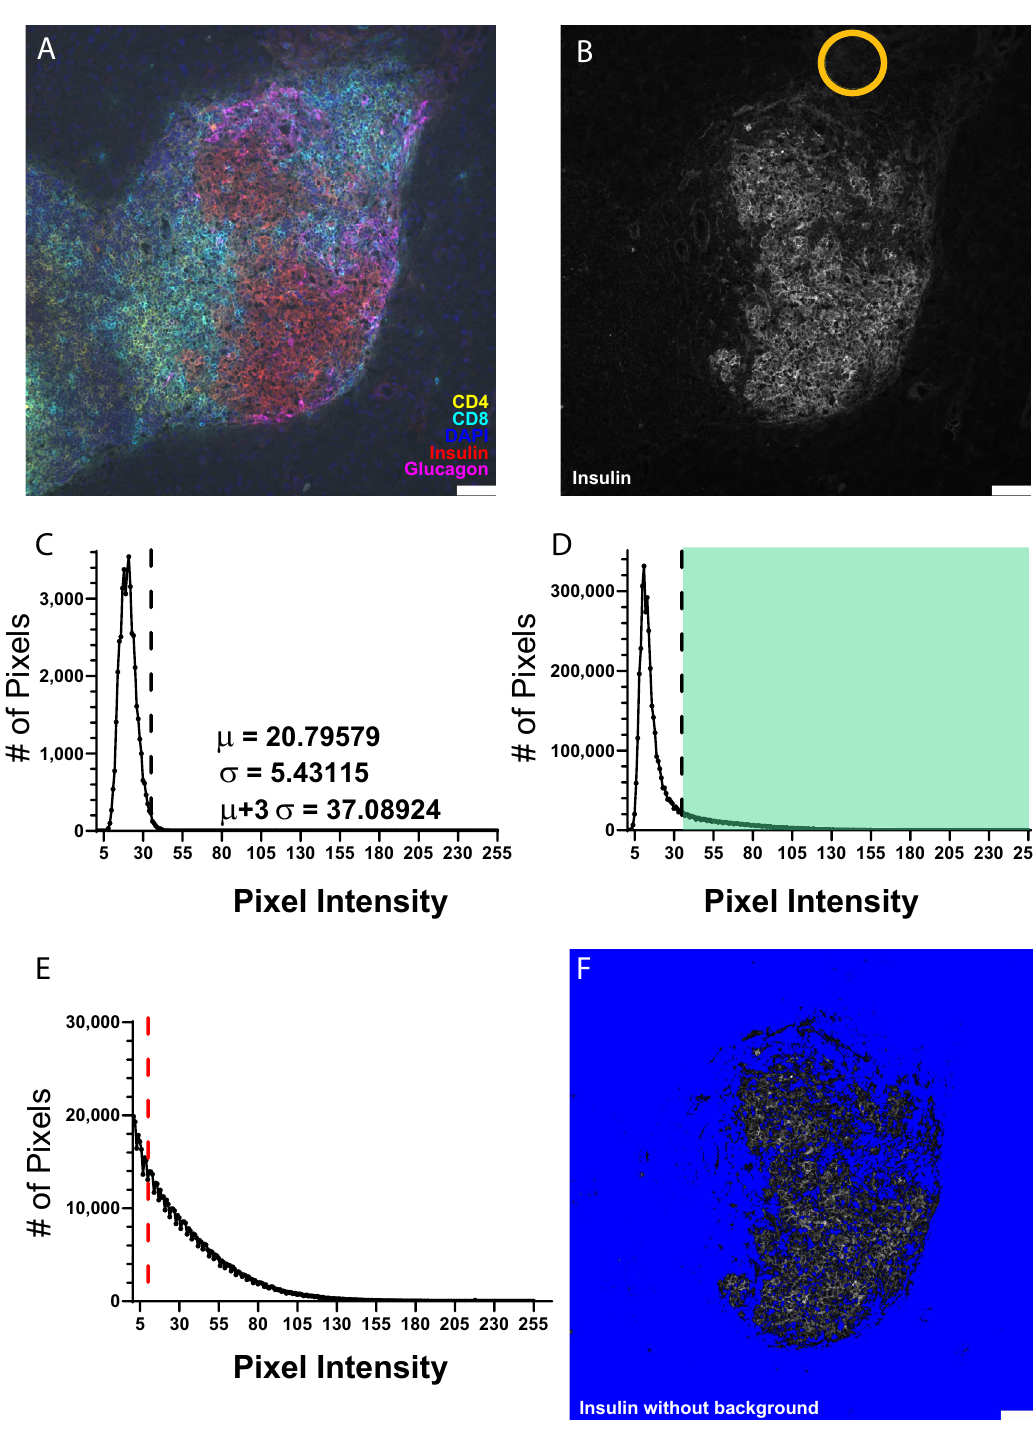
Figure 3. Region of interest (ROI)-based background correction allows dynamic elimination of false positive signals for individual islets. ( A ) Histology image of a 13-week-old non-diabetic NOD mouse islet with CD4 (yellow), CD8 (cyan), DAPI (blue), insulin (red) and glucagon (magenta) staining. ( B ) Individual 8-bit insulin image of islet from ( A ) with orange circle representing a valid ROI selection containing only negative background for subsequent signal subtraction. ( C ) Brightness histogram of the insulin background ROI from ( B ) demonstrating the default background subtraction value of three standard deviations (σ) above the mean (μ) (dotted line). ( D ) Brightness histogram of the entire insulin image from ( B ) depicting the subtraction value obtained from ( C ) (dotted line) with the shaded green region representing positive insulin signal and the unshaded region representing negative background signal. ( E ) Insulin brightness histogram after background subtraction with dotted red line representing an additional flexible cutoff value dependent upon the combination of fluorophores employed. ( F ) Individual 8-bit insulin image of islet from ( A ) after background subtraction with pixel values of 0 represented in blue to enhance visualization of remaining positive insulin signal. White bars represent 50 μm